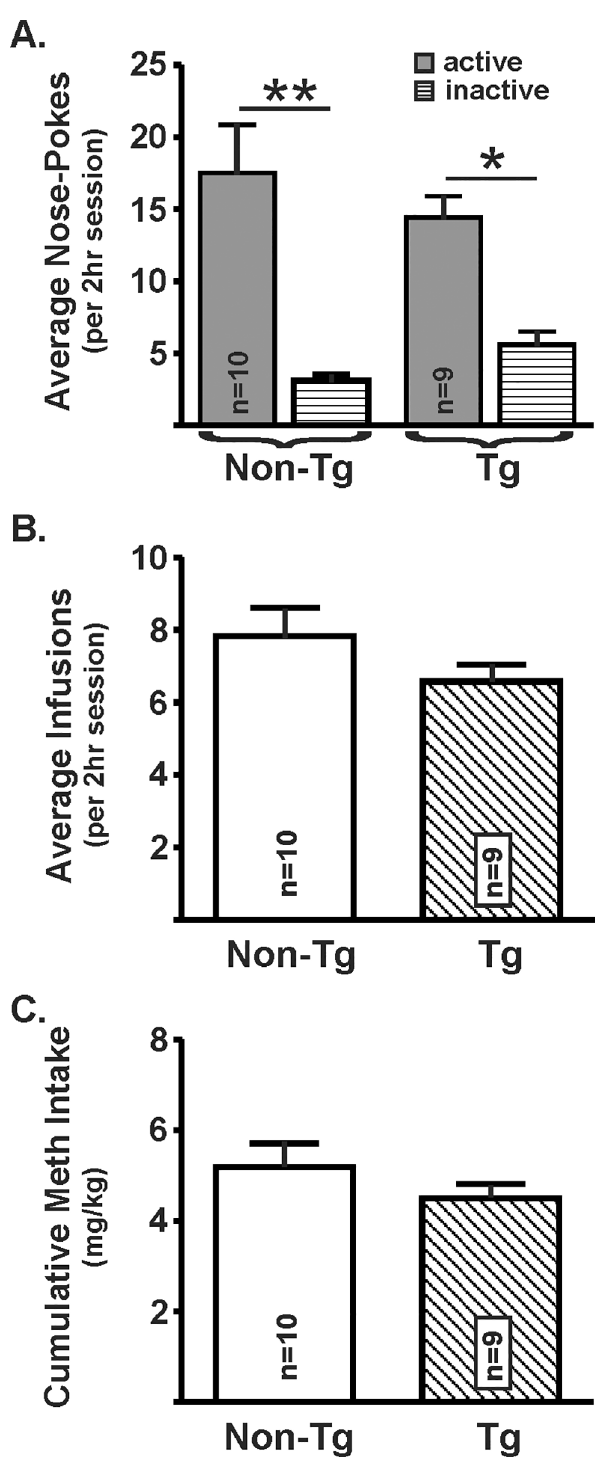
Fig 1. Methamphetamine self-administration in non-Tg and Tg rats. (A) Non-Tg and Tg rats similarly performed the methamphetamine self-administration task. Shown is the average number of nose-pokes per 2h session across 21 days by non-Tg and Tg rats. There were a greater number of active nose-pokes vs inactive nose-pokes for both genotypes. Non-Tg and Tg rats did not differ in the (B) average number of methamphetamine infusions per session, or (C) total methamphetamine intake (Student’s t -test, (cid:3) p < 0.05; (cid:3)(cid:3) p < 0.01).